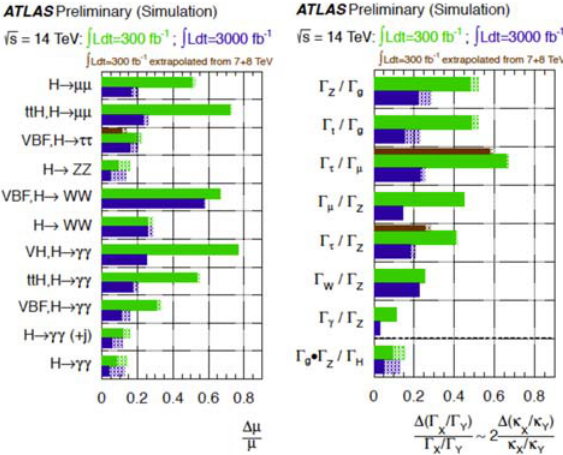
Figure 5. Expected measurement precision on the signal strength μ = ( σ × BR) / ( σ × BR) SM (left fi gure) and ratio of Higgs boson partial widths (right fi gure) without theory assumptions for 300 (light shade) and 3000 (dark shade) fb − 1 [8].